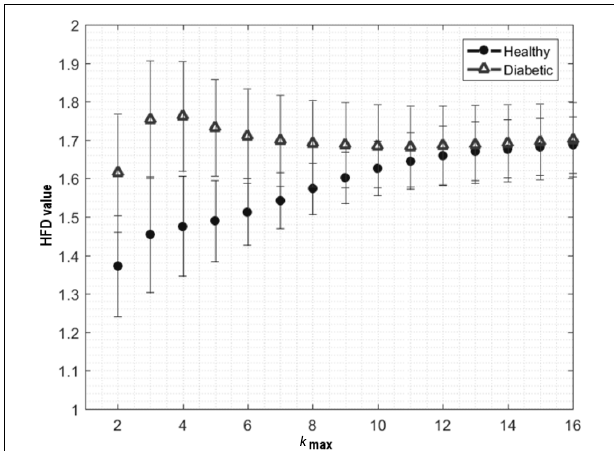
FIGURE 1 | Fluctuation of aggregated average ± SD of HFD values for healthy and diabetic subjects, calculated for k max parameter from 1 to 16. Clear differentiation between subjects obtained for k max = 5, by means of two-sided Wilcoxon ranksum test ( p <